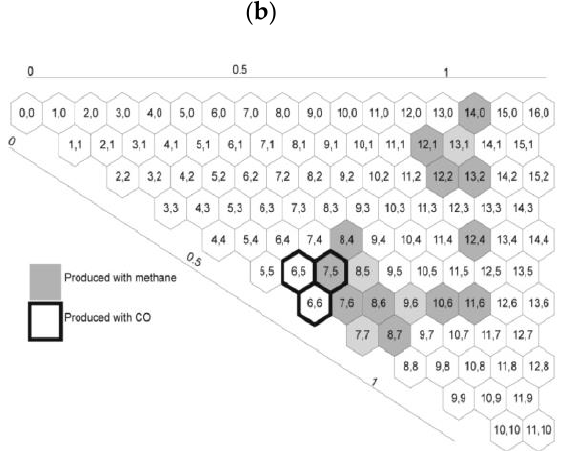
Figure 3. ( a ) Optical absorption spectra of SWCNTs grown from either CO (top) or CH 4 (bottom) as carbon feedstock. The upper spectrum is dominated by the optical absorption bands of the (6,5) chirality. The lower spectrum signifies a broader nanotube distribution. The individual absorption bands belong to: M 11 (a, b, and c), S 22 (d (8,4), e (7,5) (7,6), f (12,2), g (8,6) (8,7), h (10,6), i (12,1), and j (14,0) (11,6) (13,2) (12,4)), and S 11 (k (7,5), l (8,4) (7,6), m (12,1) (8,6), n (8,7), and o (12,4) (13,2)). ( b ) The Hamada map of SWCNTs is grown from either CO or CH 4 . The diameters for a zigzag and armchair direction are marked at 0, 0.5 and 1.0 nm [39]. Copyright 2006, American Chemical Society.